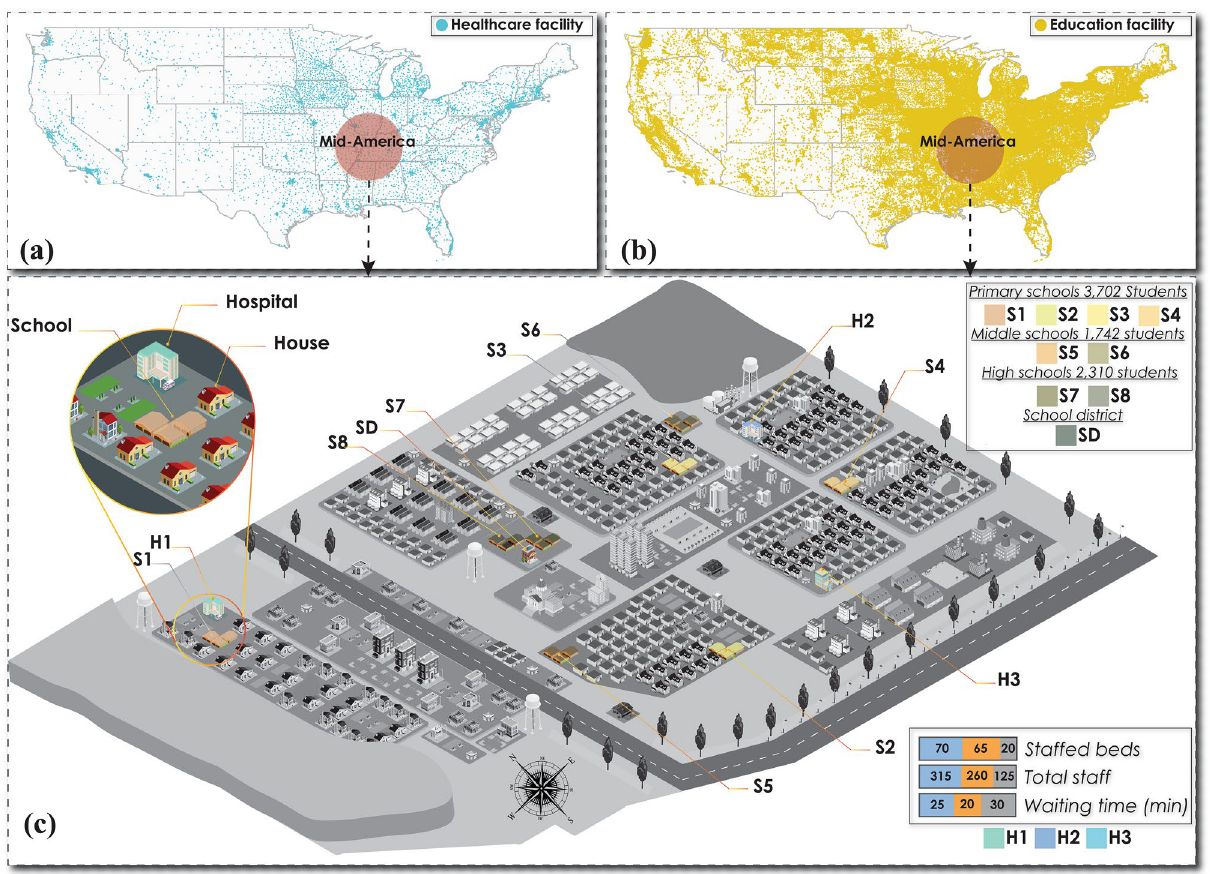
Figure 1. Healthcare and education facilities distribution in the U.S. in 2020: ( a ) healthcare, ( b ) education, and ( c ) the investigated virtual community, which is a mid-size community in the Mid-America region with 50,000 total population served by three hospitals and eight schools. Hospital capacity and school enrollment are listed in figure ( c